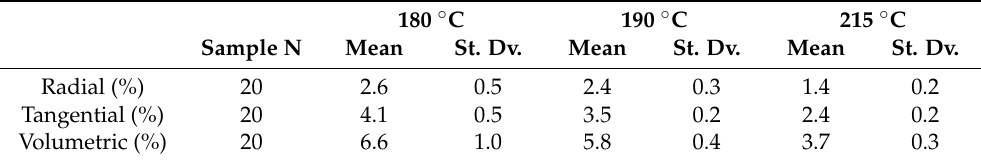
Table 2. Linear and volumetric shrinkage of heat-treated ayous wood.